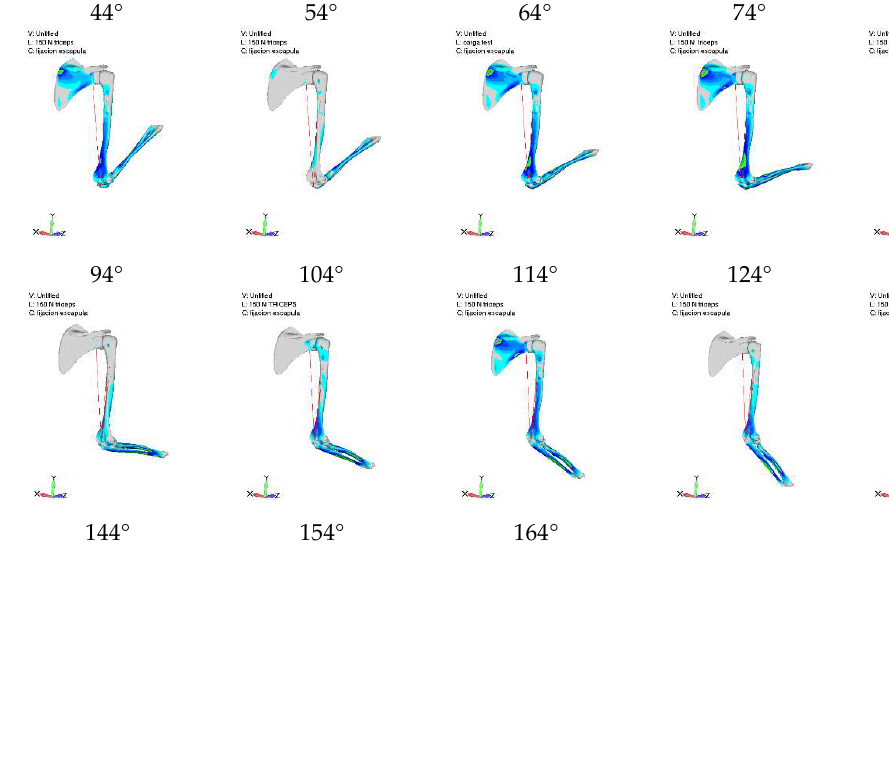
164° Figure 11. Different elbow angle configuration: bone Von Mises stress distribution under biceps loading (150 N on wrist) cases. Figures are included in more quality in Appendix A.